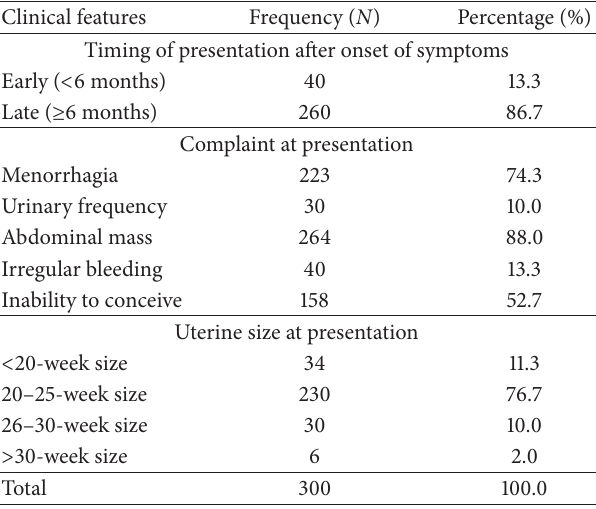
Table 4: Perception of respondents to fibroid.